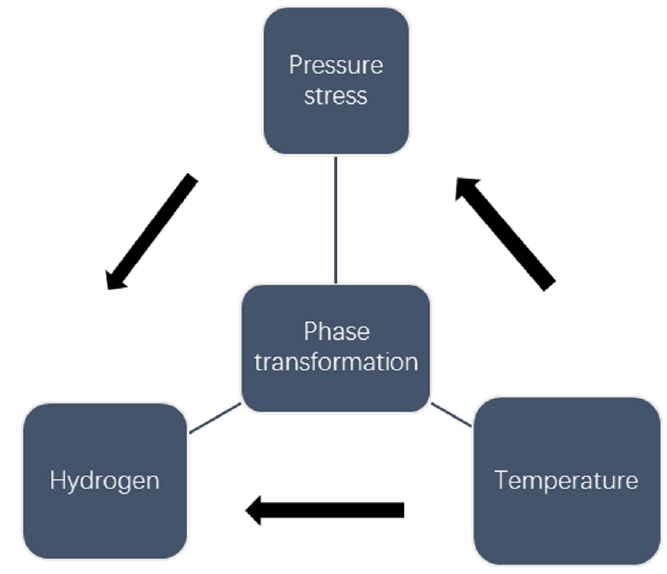
Figure 2. Simulation calculation process of multi-pass welding.